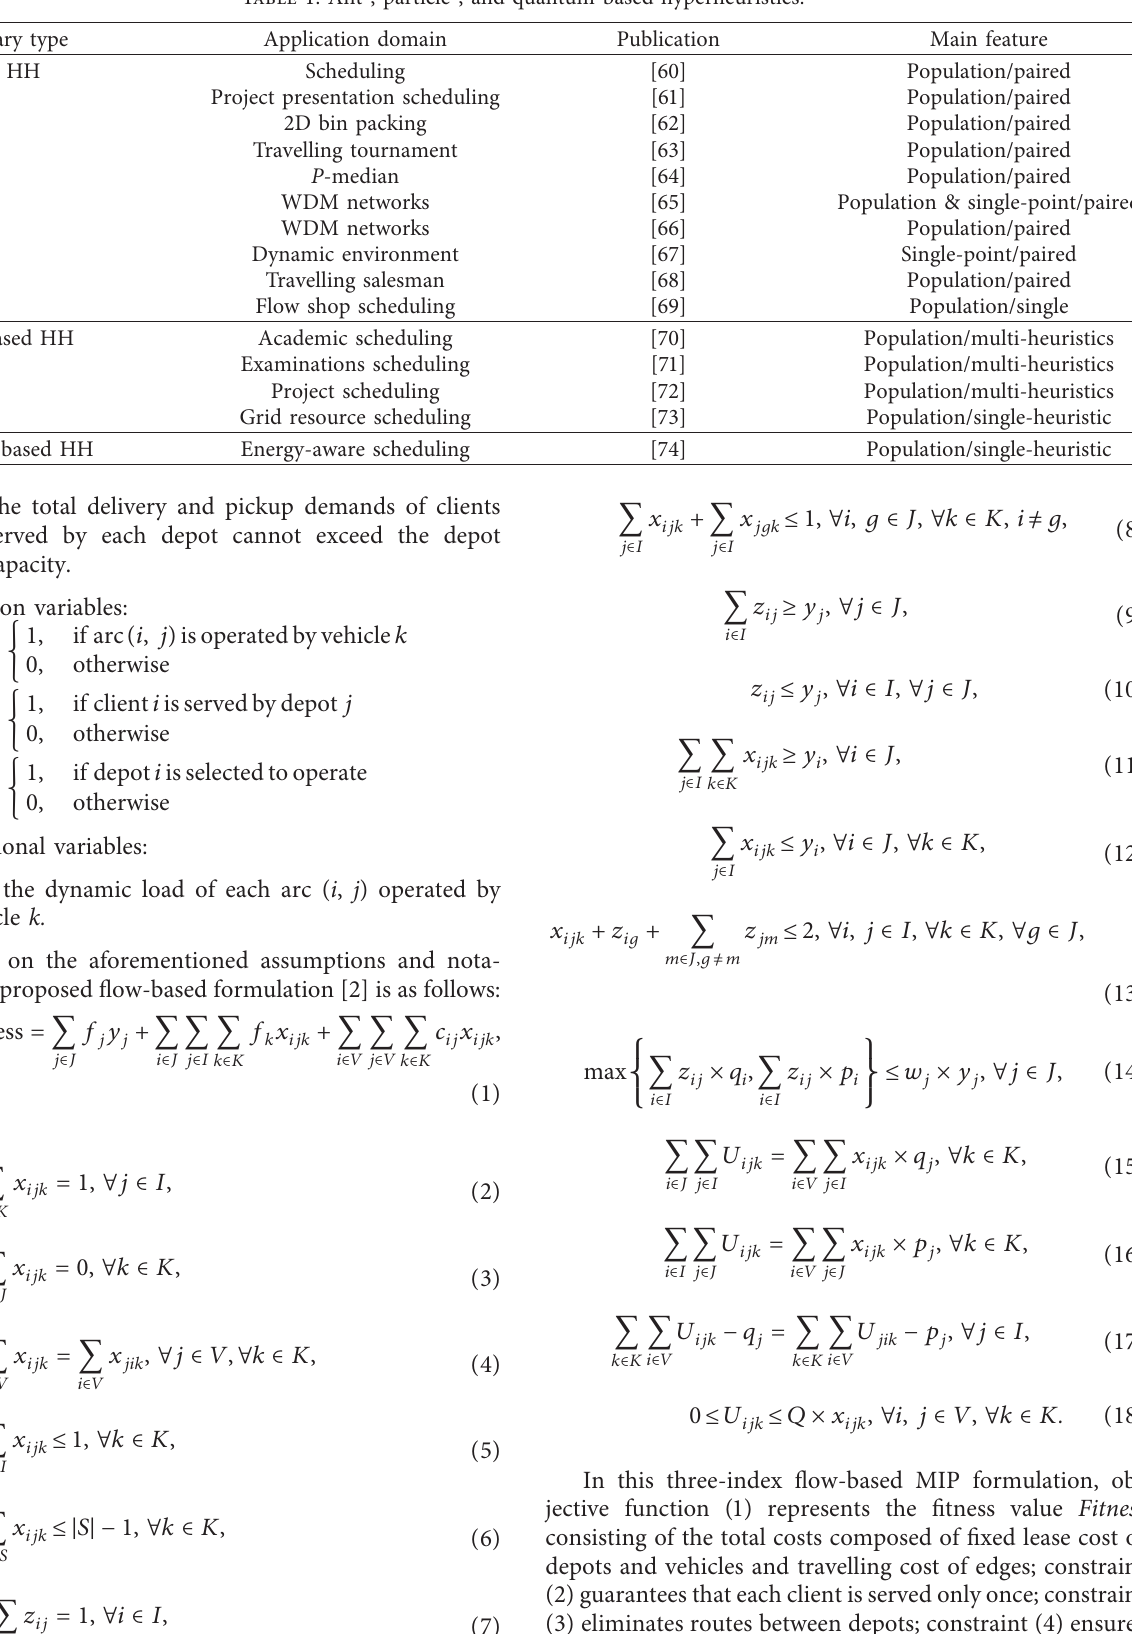
Table 1: Ant-, particle-, and quantum-based